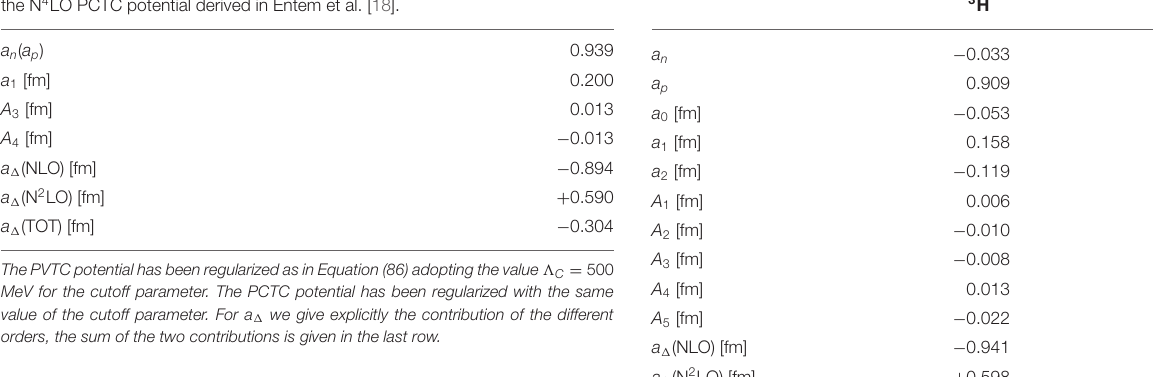
TABLE 10 | Values of the coefficients entering the expression of the deuteron EDM calculated for the χ EFT N 2 LO PVTV potential described in section 3.5 and the N 4 LO PCTC potential derived in Entem et al. [18].